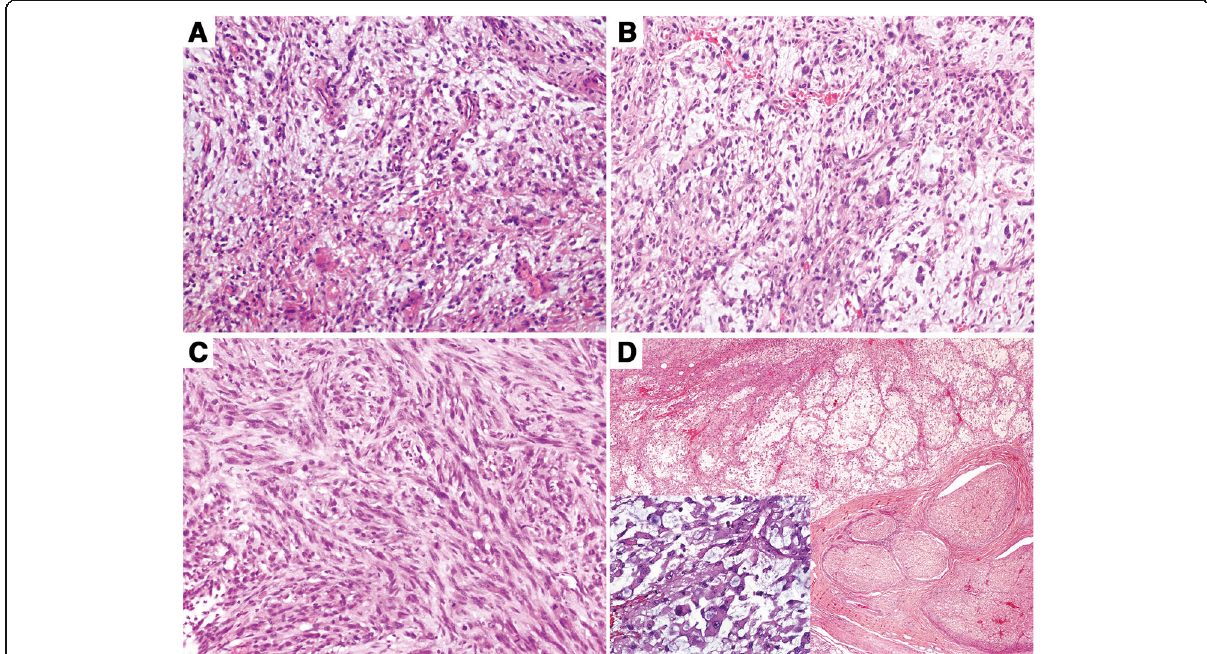
Fig. 1 Mophology of MFS: Spindle to polygonal sarcoma cells within variably myxoid stroma containing long curvilinear vessels. a : FNCLCC Grade 1 MFS; b : FNCLCC Grade 2 MFS; c : FNCLCC Grade 3 MFS; d : Epithelioid variant of MFS, tumor cells is an infiltrative multinodular growth pattern, with alternation of hypercellular and hypocellular myxoid areas. Tumor cells had epithelioid morphology with abundant eosinophilic cytoplasm and oval or plump spindle nuclei, scattered in the myxoid background